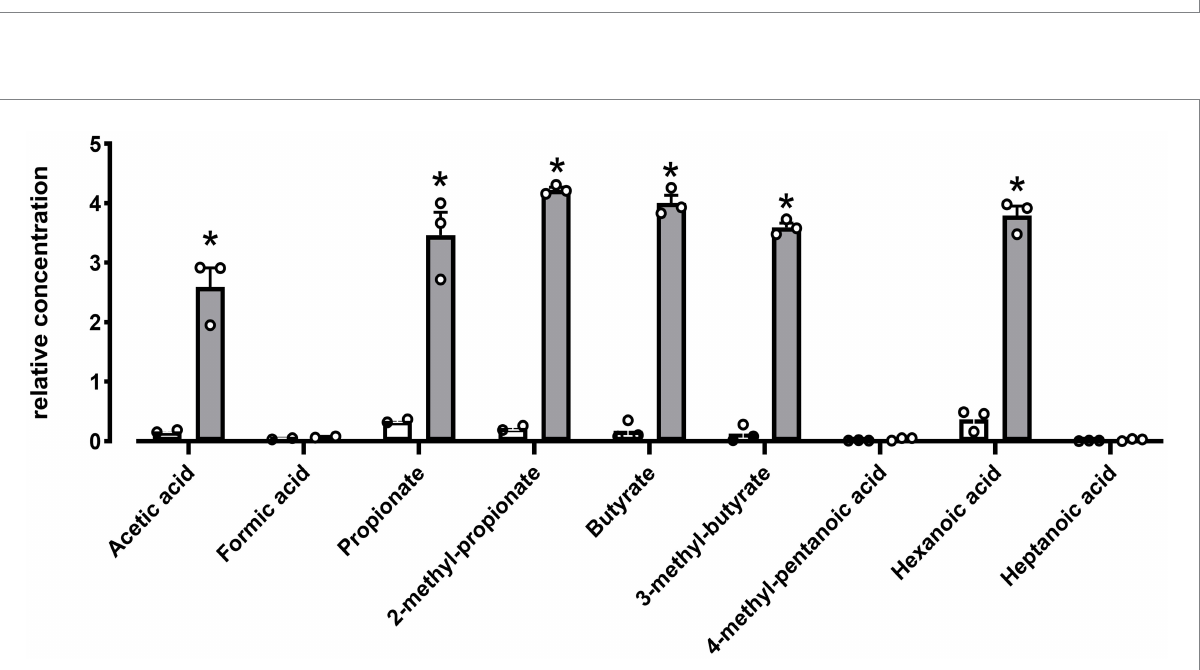
FIGURE 6 SCFA increased in DE111 ® UHT fermented milk samples. Statistical analysis performed using Multiple T test – using unpaired parametric, Two- stage step-up (Benjamini, Krieger, and Yekutieli) and * p -value ≤ 0.01. The graph presents average activities ( N = 3 ± SEM). The white bar represents the control and gray bar represent DE111 ®